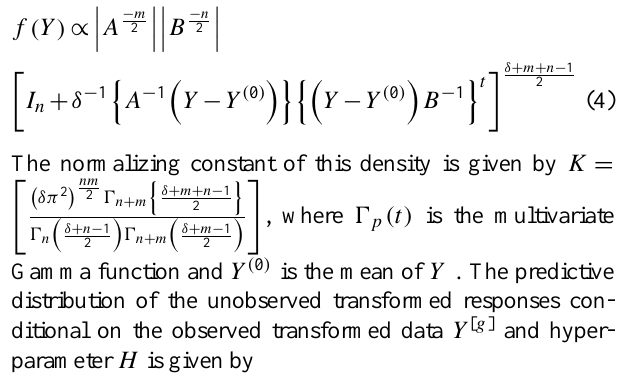
Fig. 2. The temporal mean trend aggregated over the regions.